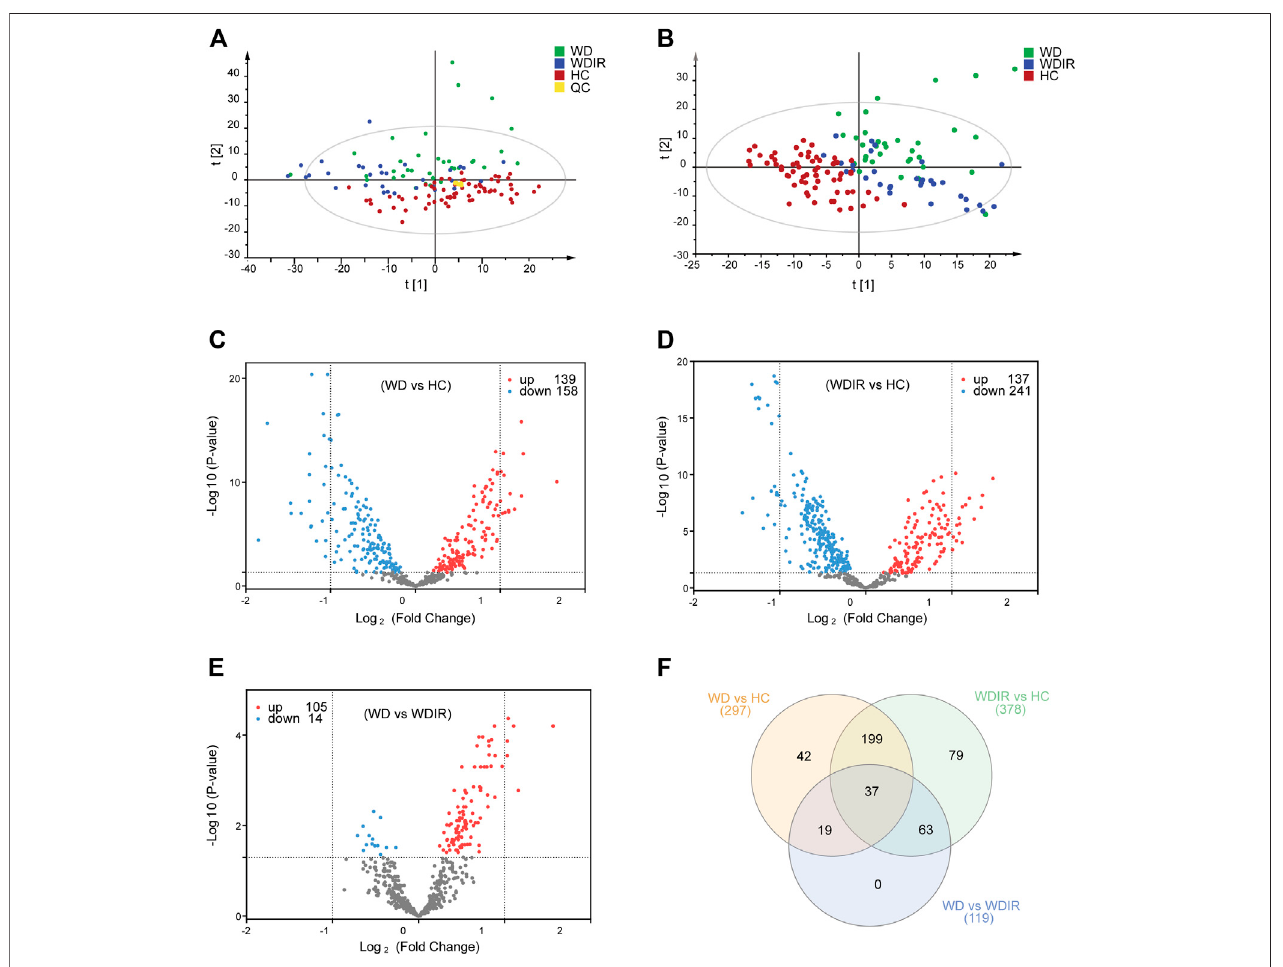
FIGURE 2 | Overview of differential lipid pro fi les in three groups. (A) Principal component analysis (PCA) was used to test the samples of the WD, WDIR and HC (R2X (cid:2) 0.893,Q2 (cid:2) 0.772). (B) Partialleastsquaresdiscriminantanalysis(PLS-DA)wasusedtoclusterthesamplesofthethreegroups(R2X (cid:2) 0.524,R2X (cid:2) 0.676,Q2 (cid:2) 0.506). (C) A volcano plot showing the dysregulated features between WD and HC (Student ’ s t-test, FDR < 0.05). (D) A volcano plot for the different lipids of WDIR and HC. (E) A volcano plot for the WD and WDIR. (F) Venn diagram displaying the number of differentially abundant metabolites that overlapped in the WD versus HC comparison (WD vs HC), WD versus WDIR comparison (WD vs WDIR), and WDIR versus HC comparison (WDIR vs HC).